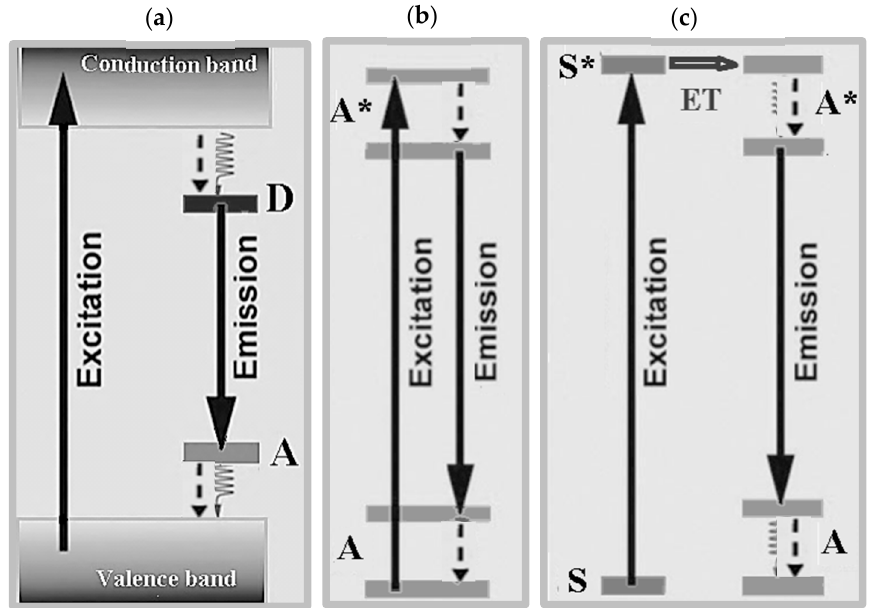
Figure 2. ( a ) Sensitization of the host lattice. ( b ) An activator element (A) gets excited to a state A* following energy absorption and emits radiatively through down-conversion. ( c ) The energy absorbed by a sensitizer S having an excited state S* is transferred to an excited state of a nearby activator dopant (A*) that emits radiatively. Dashed lines refer to non-radiative energy relaxation.